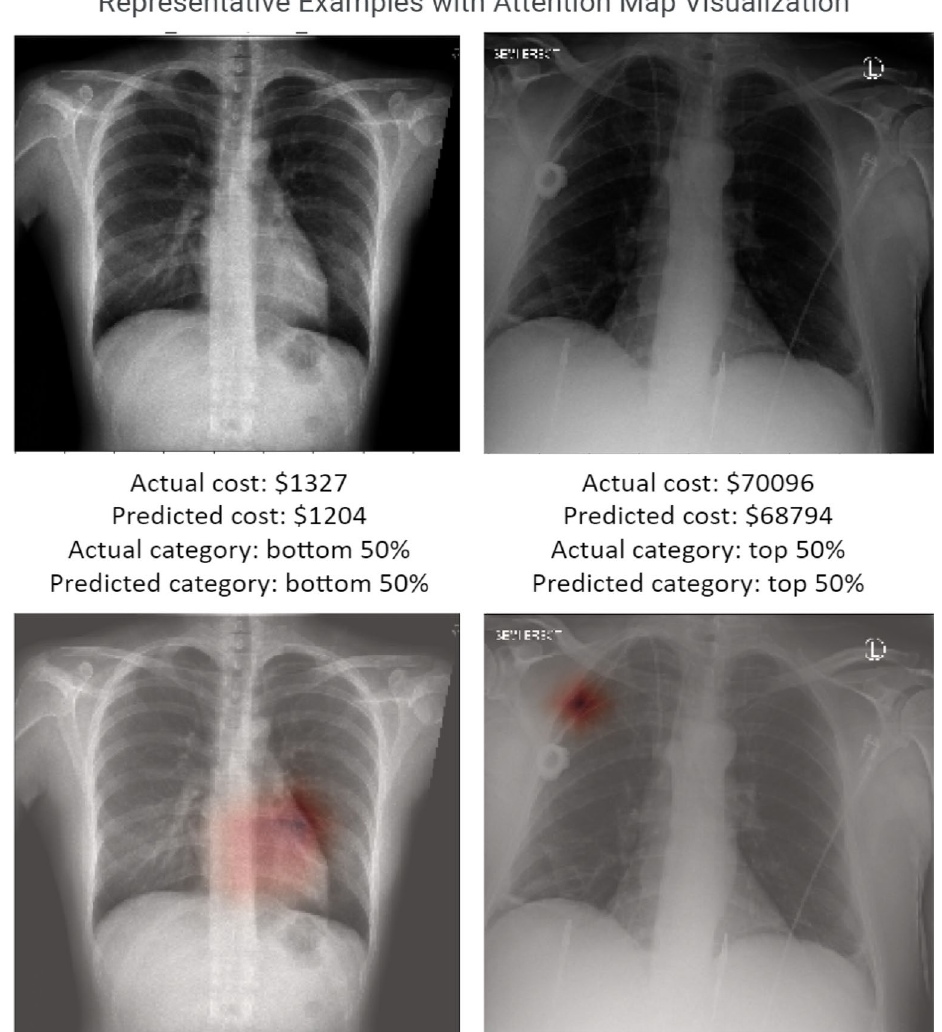
Figure 4. Examples of chest radiographs pairing with Grad-CAM maps of the chest radiographs generated using 1 year data. The top images are the original images in grayscale. The descriptions showed that true and predicted cost values and categories. The bottom images highlighted the regions that are of most importance to the deep learning model’s decision (left: attention on the heart; right: attention on the chest Port-A-Cath). See Suppl. Fig. S6 for CXR with poor